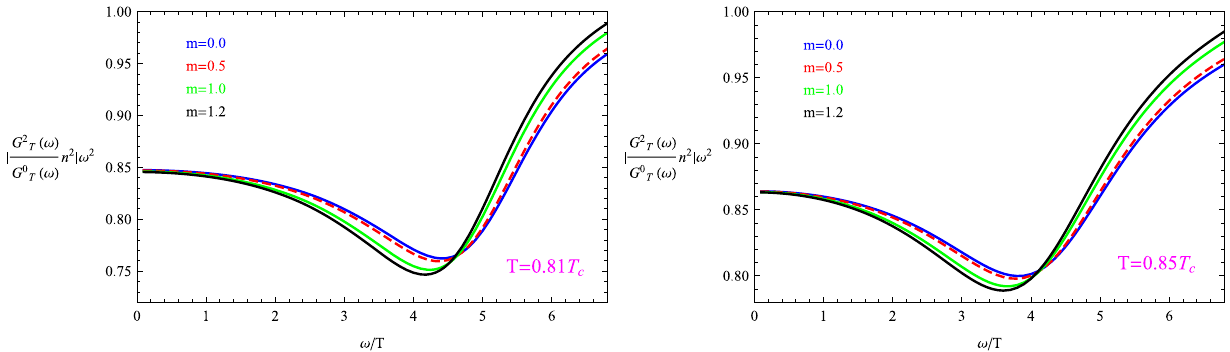
(ω) 2 T Fig. 6 | G n 2 | ω 2 as a function of ω/ T with the fixed temperatures T = 0 . 81 T c (left) and T = 0 . 85 T c (right) for different values of the graviton G 0 T (ω) mass parameter, i.e., m = 0 . 0 (blue), 0 . 5 (red dotted), 1 . 0 (green) and 1 . 2 (black), respectively. We have set the coupling parameter η = 0 in the